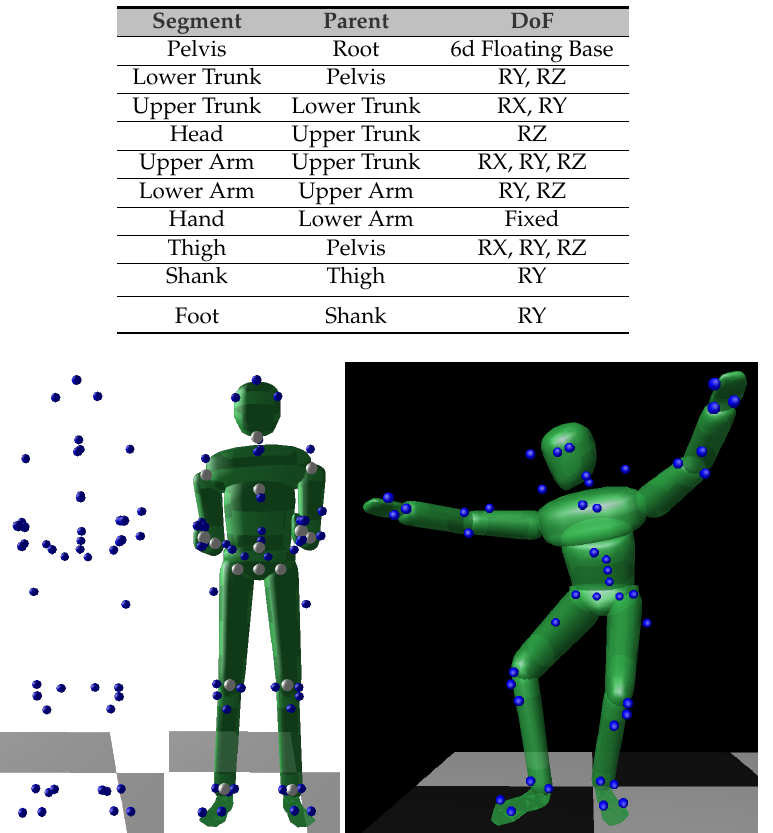
Table 1. Description of the kinematic structure of the model with all degrees of freedom.